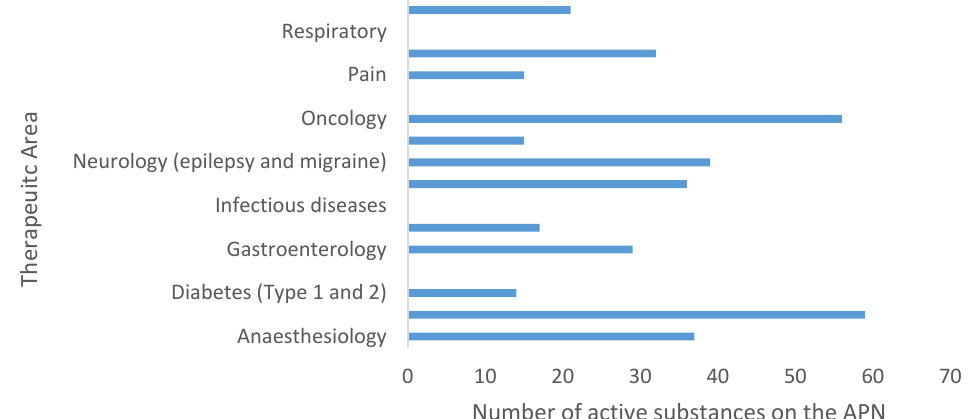
Figure 6. Number of active substances on the APN list per EMA therapeutic area that require additional